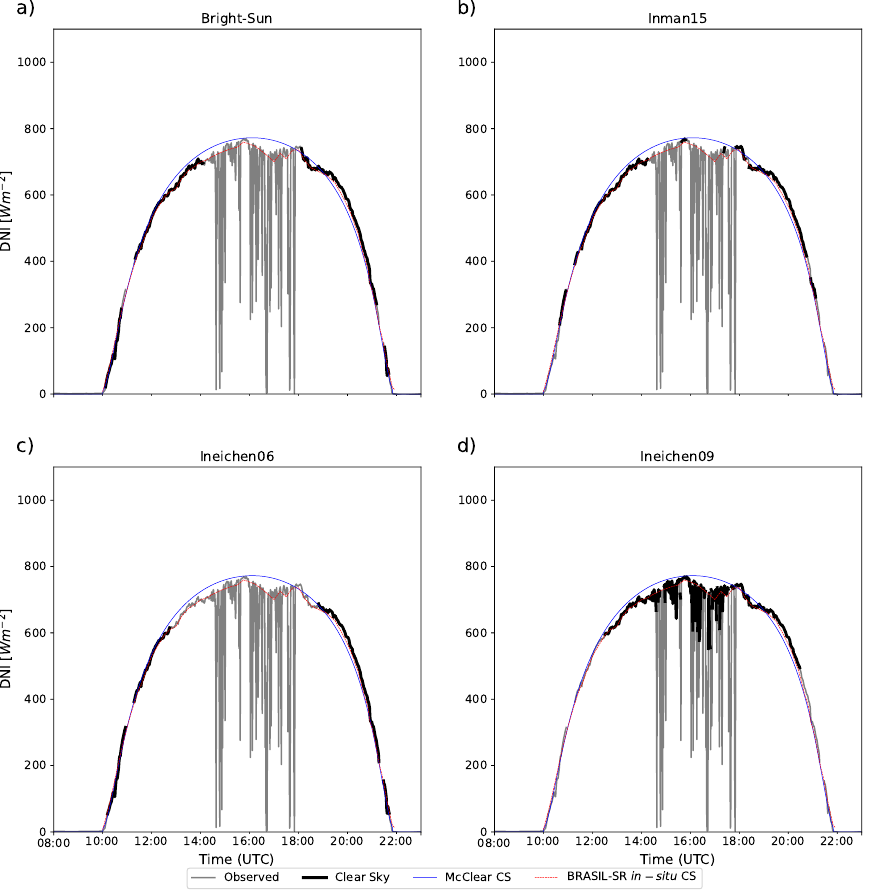
Figure 3. Data flagged as clear-sky for ARM_Manacapuru on 19 September 2015, according to algorithms of Bright-Sun ( a ) Inman15 ( b ), Ineichen06 ( c ) and Ineichen09 ( d ). Clear-sky results from McClear and from BRASIL-SR ( in-situ experiment ) are presented as well for